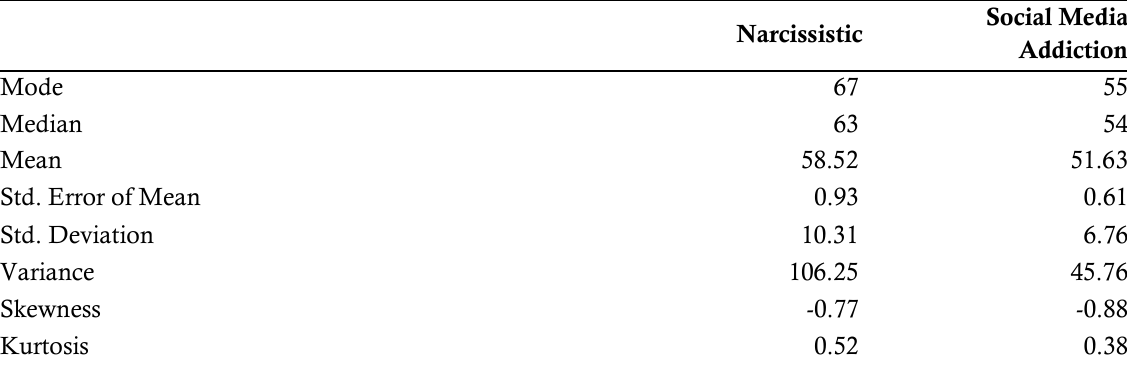
Table 3. Narcissistic Descriptive Results and Social Media Addiction